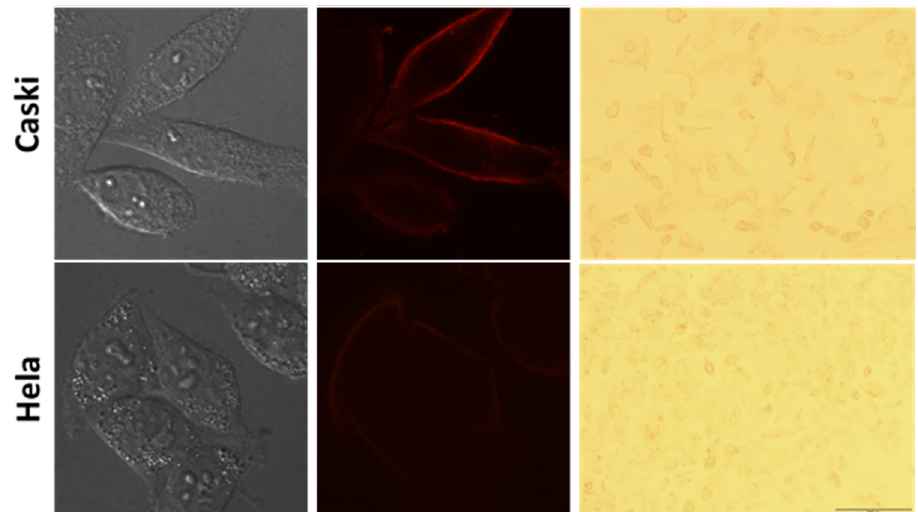
Figure 7. Quantitatively distinguish cervical cancer cells with different invasion/metastasis capabil- ities. The first column on the left is the bright field images, the middle column is the representative images of cells labeled with Au clusters (8 μ M for 30 min), the third column is the representative images of the clusters labelled-cells after DAB color imaging.